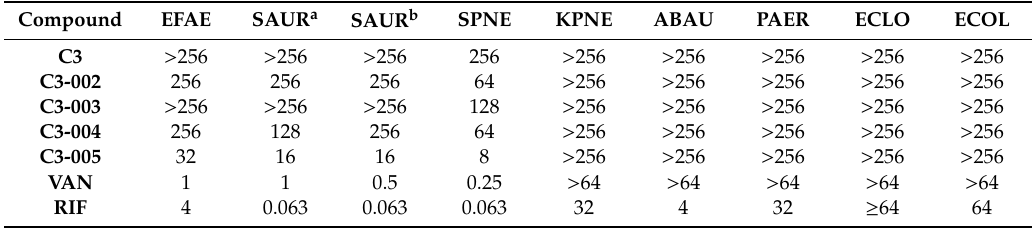
Table 1. Antimicrobial activity of C3 and derivatives.